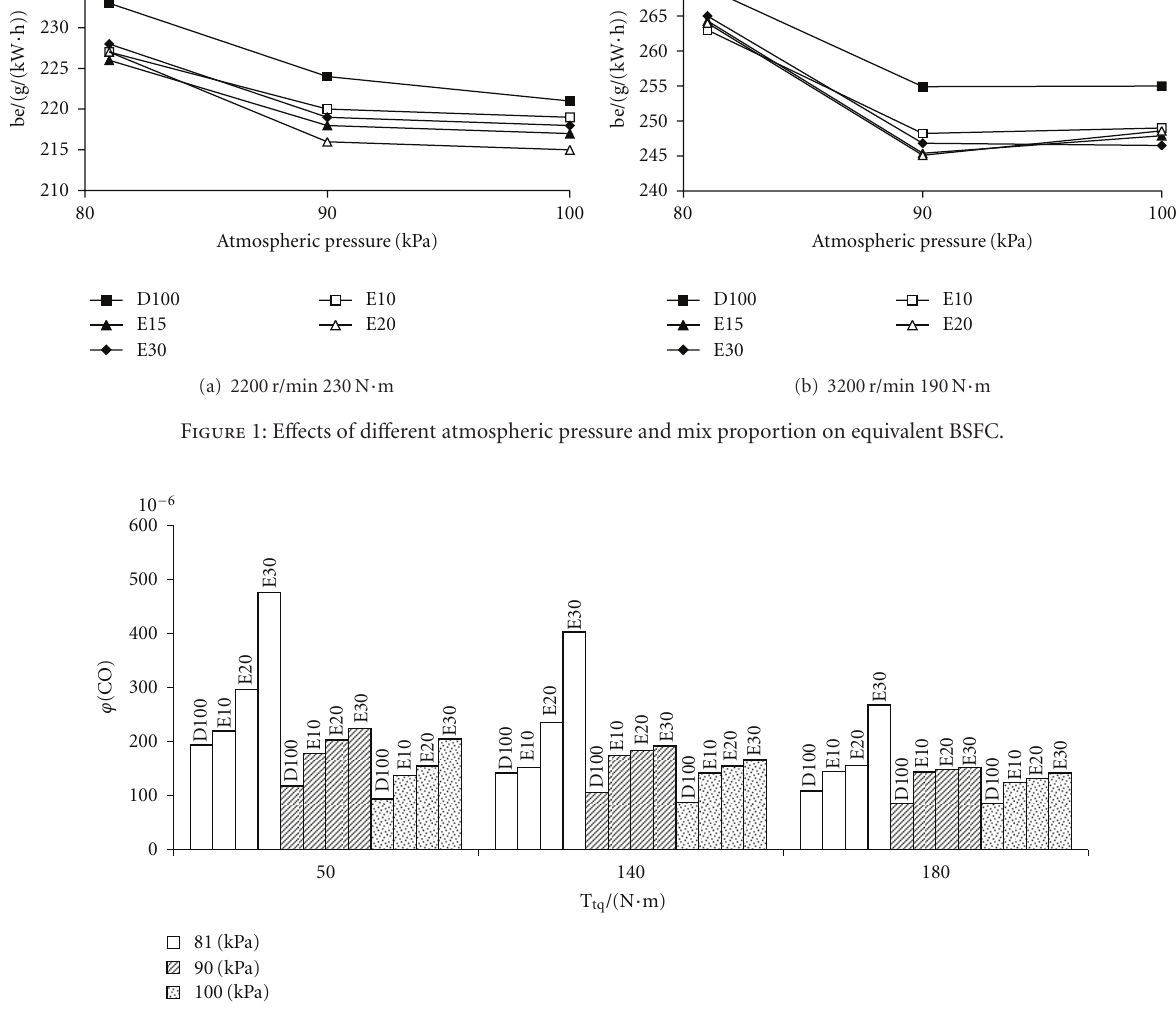
Figure 2: Comparison of HC emission of di ff erent atmospheric pressure and mix proportion at speed 1400